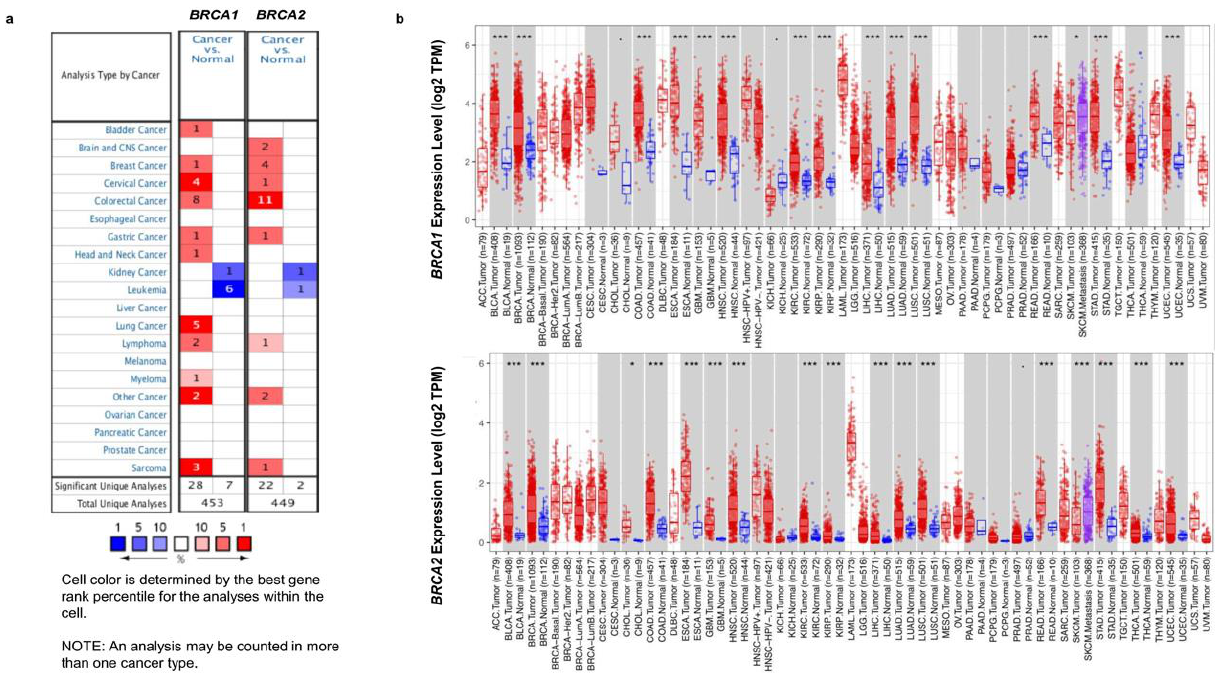
Figure 1. Expression of BRCA1/2 mRNA in cancer vs. normal (Oncomine and TCGA database). ( a ) This graphic generated by Oncomine (https://www.oncomine.org/resource/login.html, accessed on 10 February 2022) indicates the numbers of datasets with statistically significant ( p < 0.01) mRNA overexpression (red) or downexpression (blue) of BRCA1/2 (different types of cancer vs. correspond- ing normal tissue). The threshold was designed with the following parameters: p value of 1 × 10 − 4 , fold change of 2, and gene ranking of 10%. ( b ) Human BRCA1/2 expression levels in different tumor types from TCGA database were determined by TIMER 2.0 (http://timer.cistrome.org, accessed on 10 February 2022) (* p < 0.05; *** p < 0.001). Table 1. The expression of BRCA1/2 in BRCA in the Oncomine database.